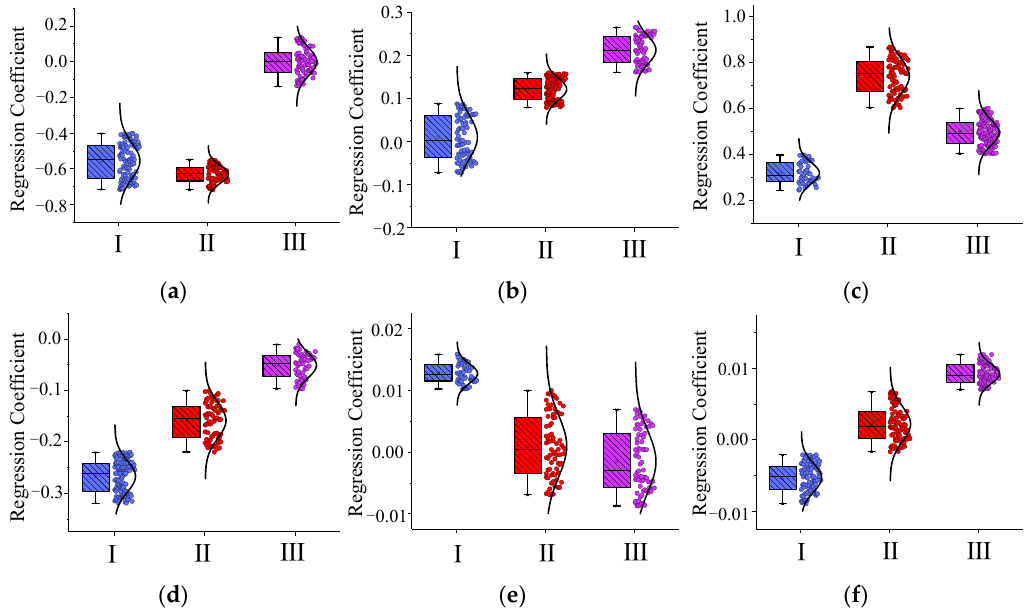
Figure 6. Second-order clustering results of the regression coefficients of the geographically weighted regression model at the 80 km analysis scale. ( a ) The width of the multifractal spectrum; ( b ) The difference of the multifractal spectrum; ( c ) Slope; ( d ) Average elevation; ( e ) Elevation maximum; ( f ) Elevation minimum.